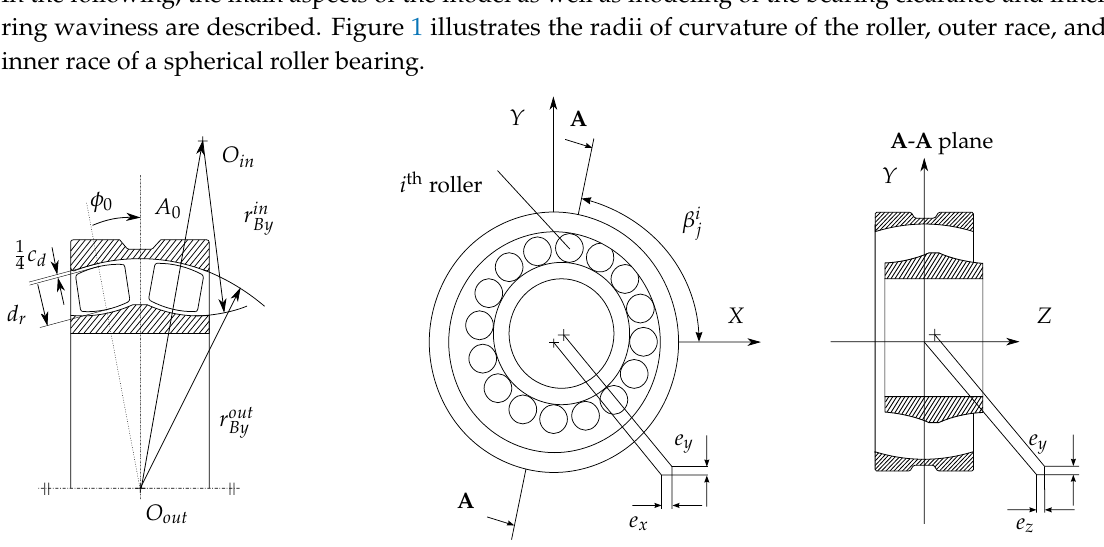
Figure 1. Parameters in a spherical roller bearing and radii of curvature of the roller, outer race, and inner race, and axial and transverse cross-sections of the studied